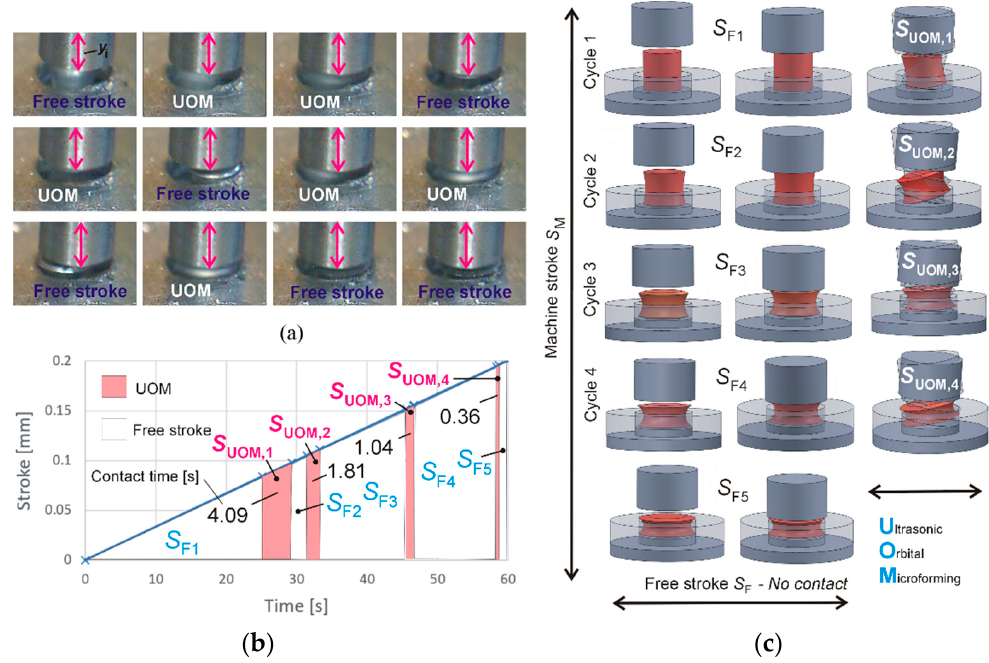
Figure 6. Analysis of the video documentation of the UOM process: ( a ) Determination of punch position at the borders of the UOM phases; ( b ) Graphical interpretation of the process phases; and ( c ) Visualization of the process cycles.